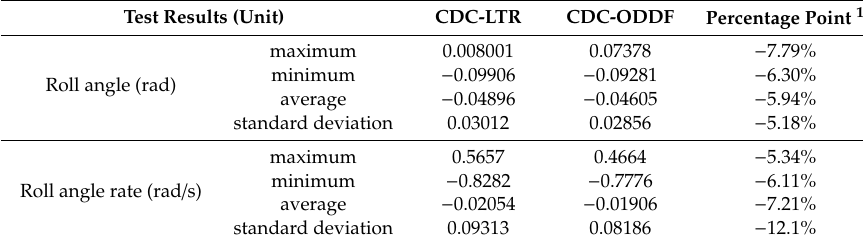
Table 4. Main comparison results of fishhook test (CDC-LTR,